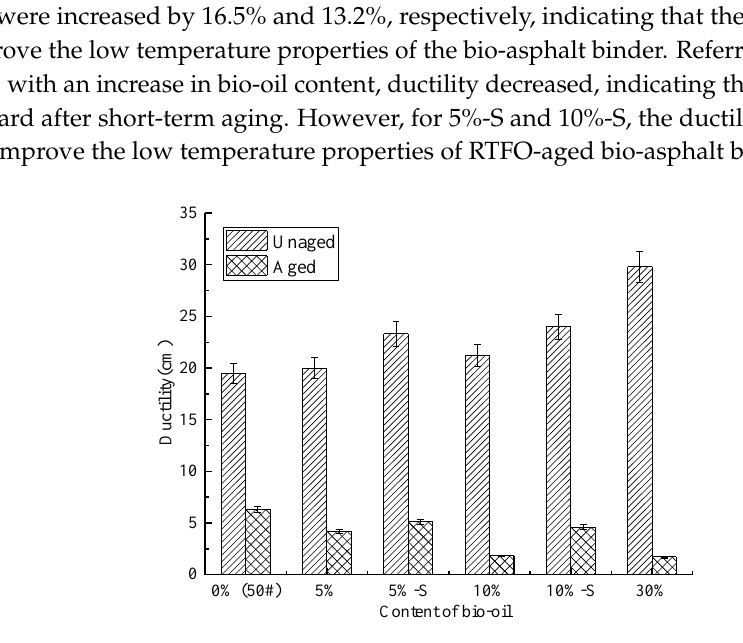
Figure 5. Ductility of unaged and RTFO aged bio-asphalt.